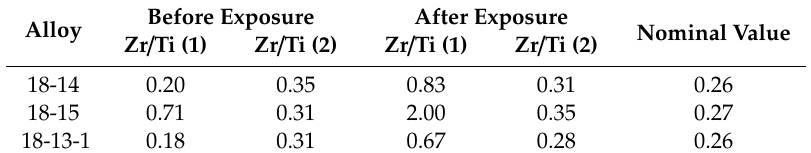
Table 9. Concentration ratio Zr / Ti for the 18-14, 18-15, and 18-13-1 alloys derived from the AES results obtained from the uppermost layer (1) and the near-surface layer (2), before and after exposure to Hanks’ solution for 604.8 ks; the last column provides nominal Zr / Ti concentration ratio values for each alloy. Before Exposure After Exposure Alloy Nominal Value Zr / Ti (1) Zr / Ti